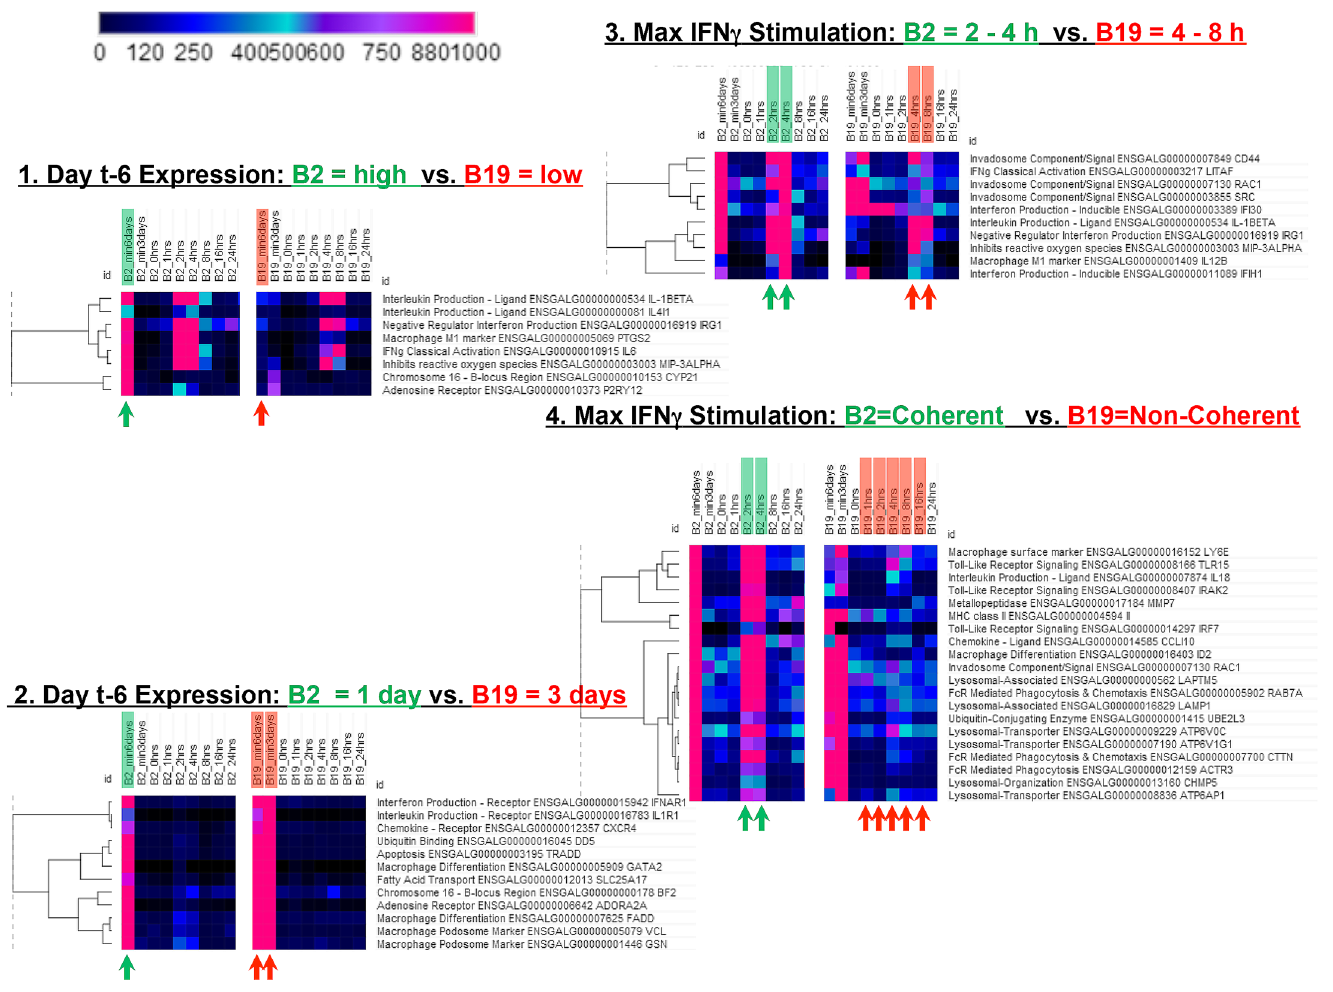
Fig 3. Examples of divergent gene expression patterns observed in B2 and B19 haplotype macrophages. Four distinct patterns were identifiedas representative of the types of divergentgene expressionthat re-occur across many genes involvedin macrophage differentiation, activationand function in B2 versus B19 macrophages. 1. Day t-6: B2 high vs B19 low . This divergentpattern exhibits strong expressionof geneson day -6 in the B2 birds while relatively low levels of expressionare observedin the B19 birds at the same time point. Genes of interest includean adenosinereceptor(P2RY12)2. Day t-6: B2 = 1 day vs. B19 = 3 days. This exampleof divergentpatterns is the singlepeak of day t-6 gene expressionin the B2 haplotypecells